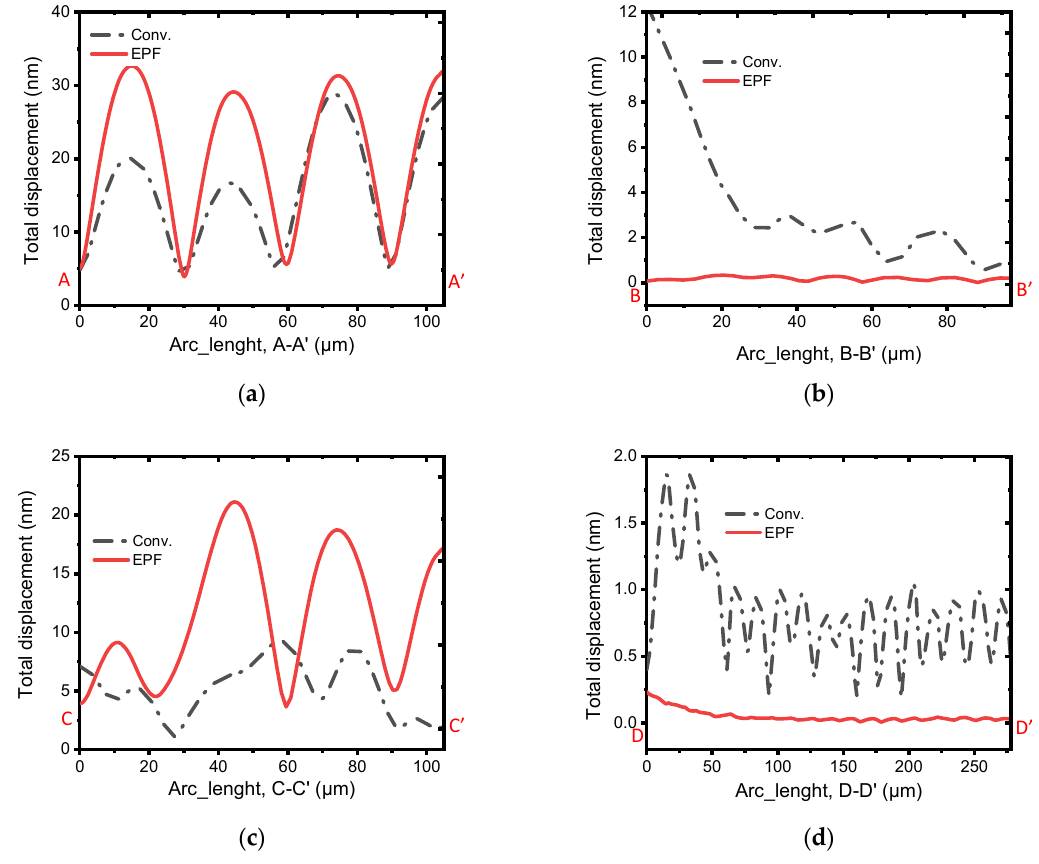
Figure 5. Illustration of the total displacement fields ( µ m) in the 7th-order width extension modes of the conventional and EPF resonators across the lines ( a ) A–A′, ( b ) B–B′, ( c ) C–C′, and ( d ) D–D′. The significantly higher vibration at the tether and the anchoring boundary of the conventional resonator compared to the others revealed the higher anchor loss endured by it.